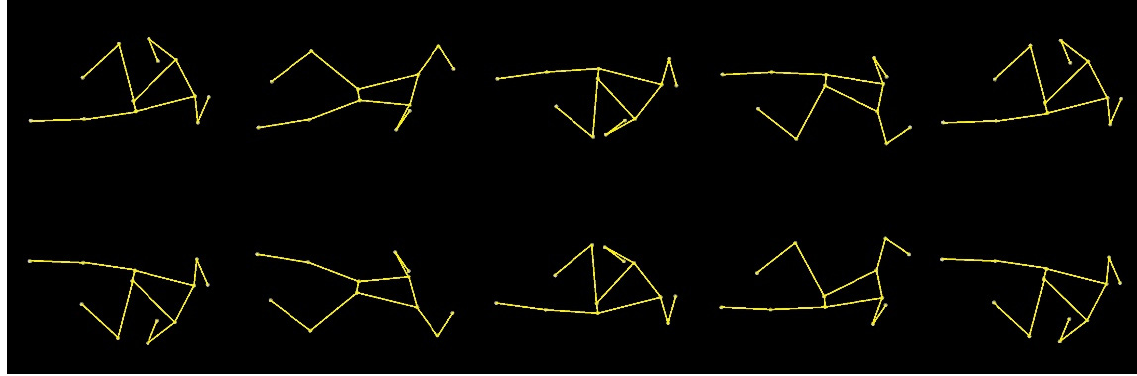
Figure 3. Sequential phases of a full cycle of motions for the right side—upper row and left side—lower row.